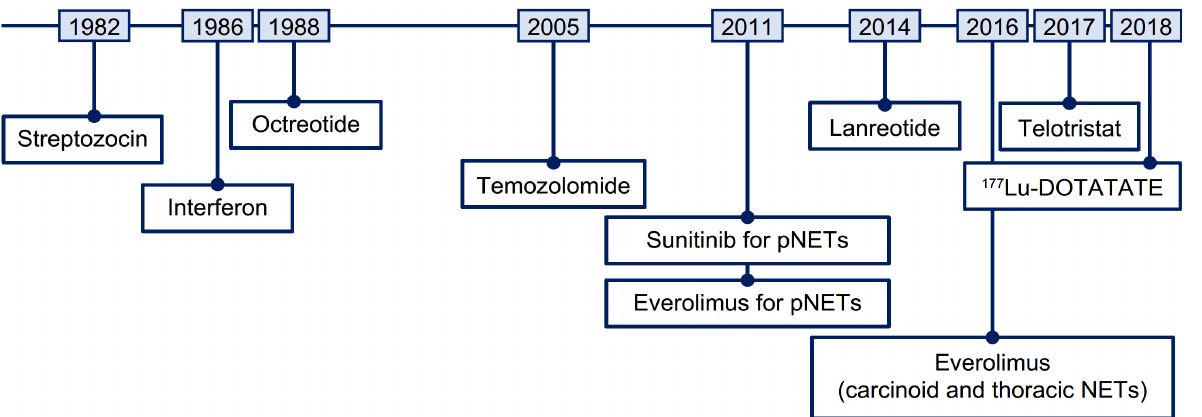
Figure 1. Timeline of therapies approved for the treatment of NETs. 177 Lu, lutetium-177; NET, neuroendocrine tumor; pNET, pancreatic neuroendocrine tumor.